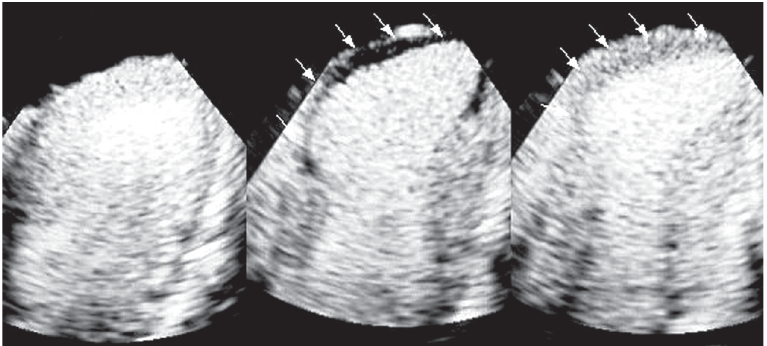
Figure 5. Wall motion abnormal- ity (WMA) and perfusional myo- cardial defect (PMD) areas de- termined by real time myocar- dial contrast echocardiography at baseline, at 20 min of left an- terior descending coronary ar- tery (LAD) occlusion and after 30 min of reperfusion in the stunned model. After reperfu- sion there was maintenance of WMA area and reduction of PMD area to almost zero. *P < 0.05 for baseline vs LAD occlu- sion; + P < 0.05 for LAD occlu- sion vs reperfusion (ANOVA).